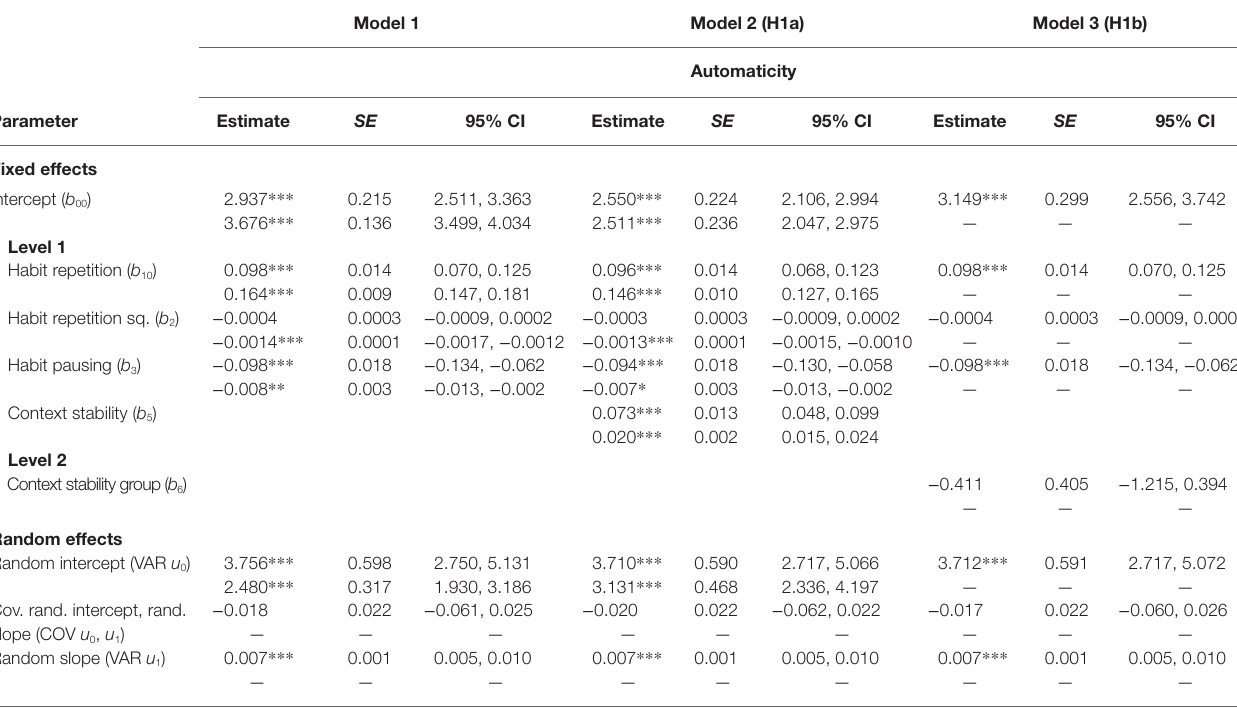
TABLE 2 | Multilevel regressions of automaticity on context stability based on controlled study data with manipulated context stability (Study 1, upper value) and real- life user data (Study 2, lower value).